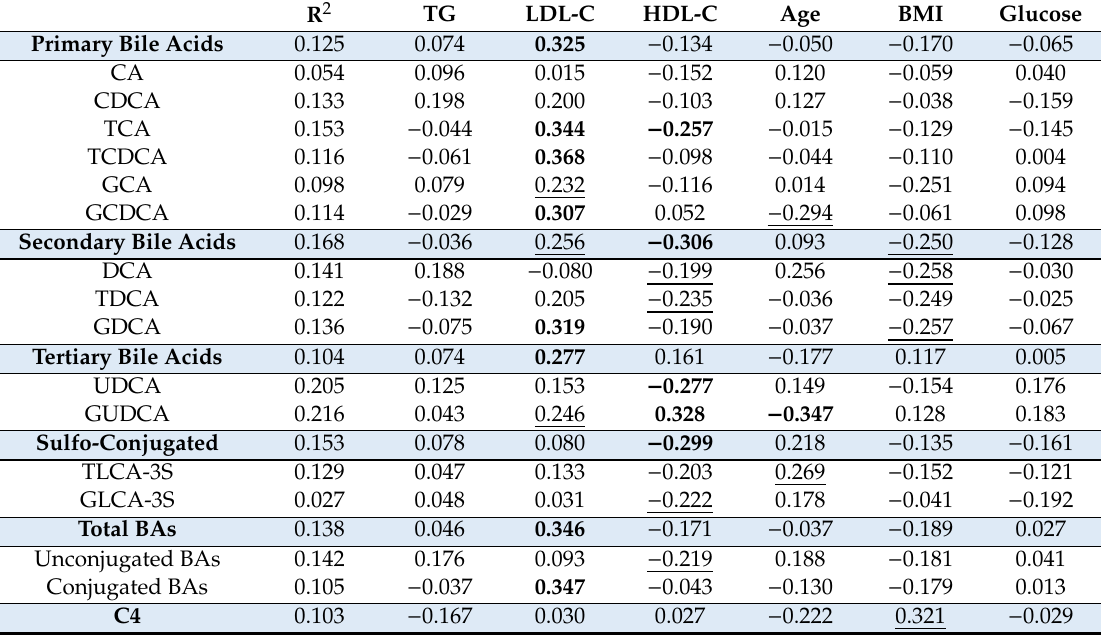
Values indicated standardized β regression coe ffi cient. TG: fasting triglycerides; LDL-C: LDLC-Cholesterol; HDL-C: HDL-Cholesterol; BMI: Body Mass Index. Statistically significant and independent associations are highlighted in bold face while trends ( p < 0.01) are